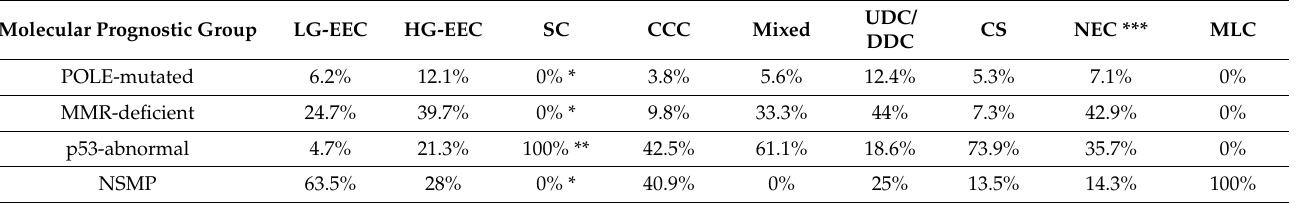
Table 3. Prevalence of the 4 TCGA molecular prognostic groups across different histotypes of endometrial